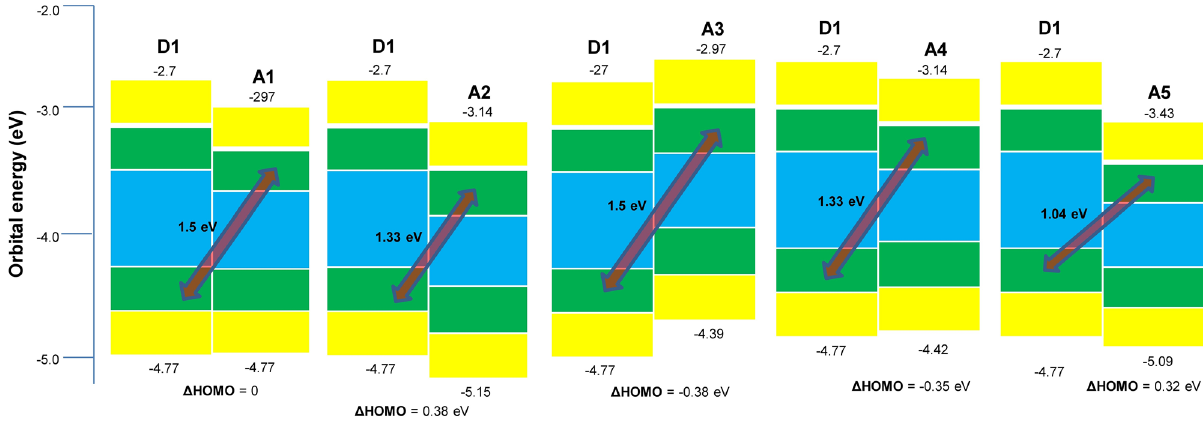
Figure 5. V oc and ∆HOMO of A1 – A5 with D1 polymer